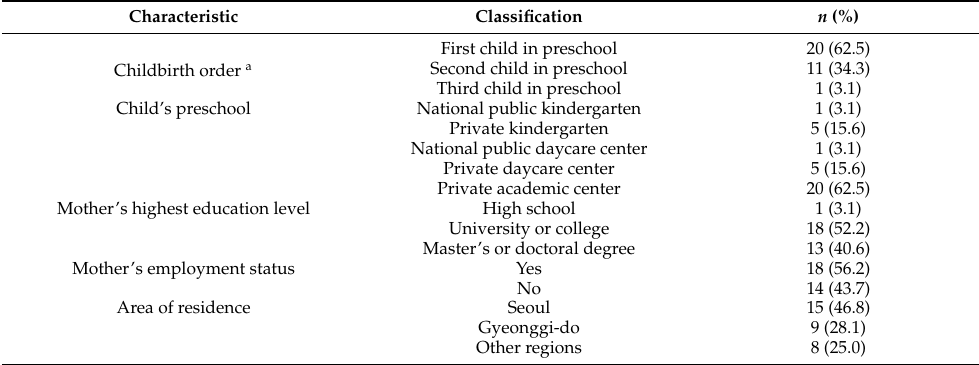
Table 1. Characteristics of study participants and their preschool children ( n = 32).